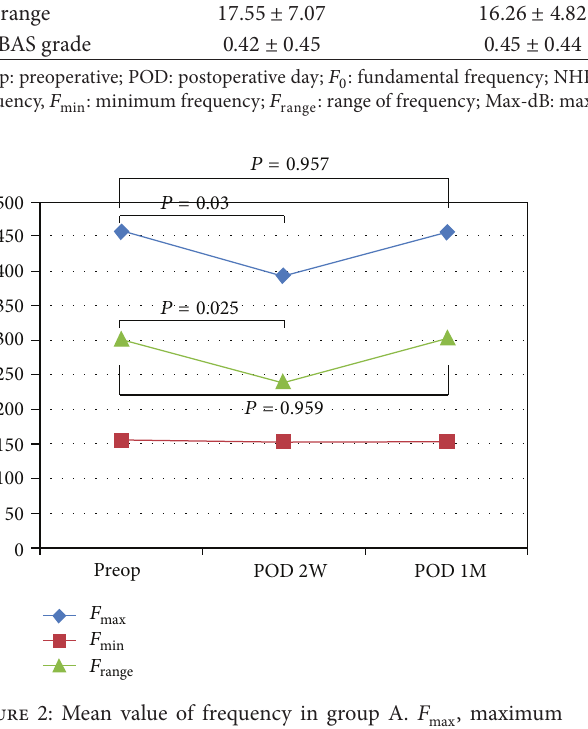
, range of frequency; range